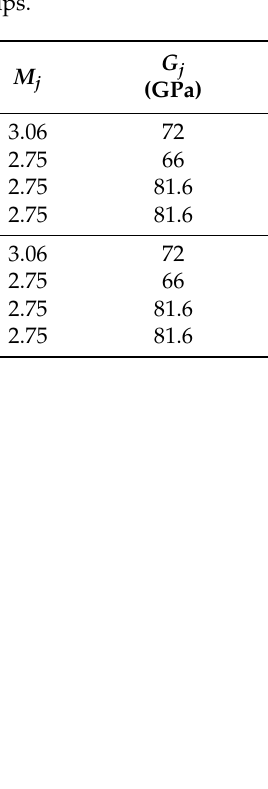
Table 2. Parameters for constructing constitutive relationships.